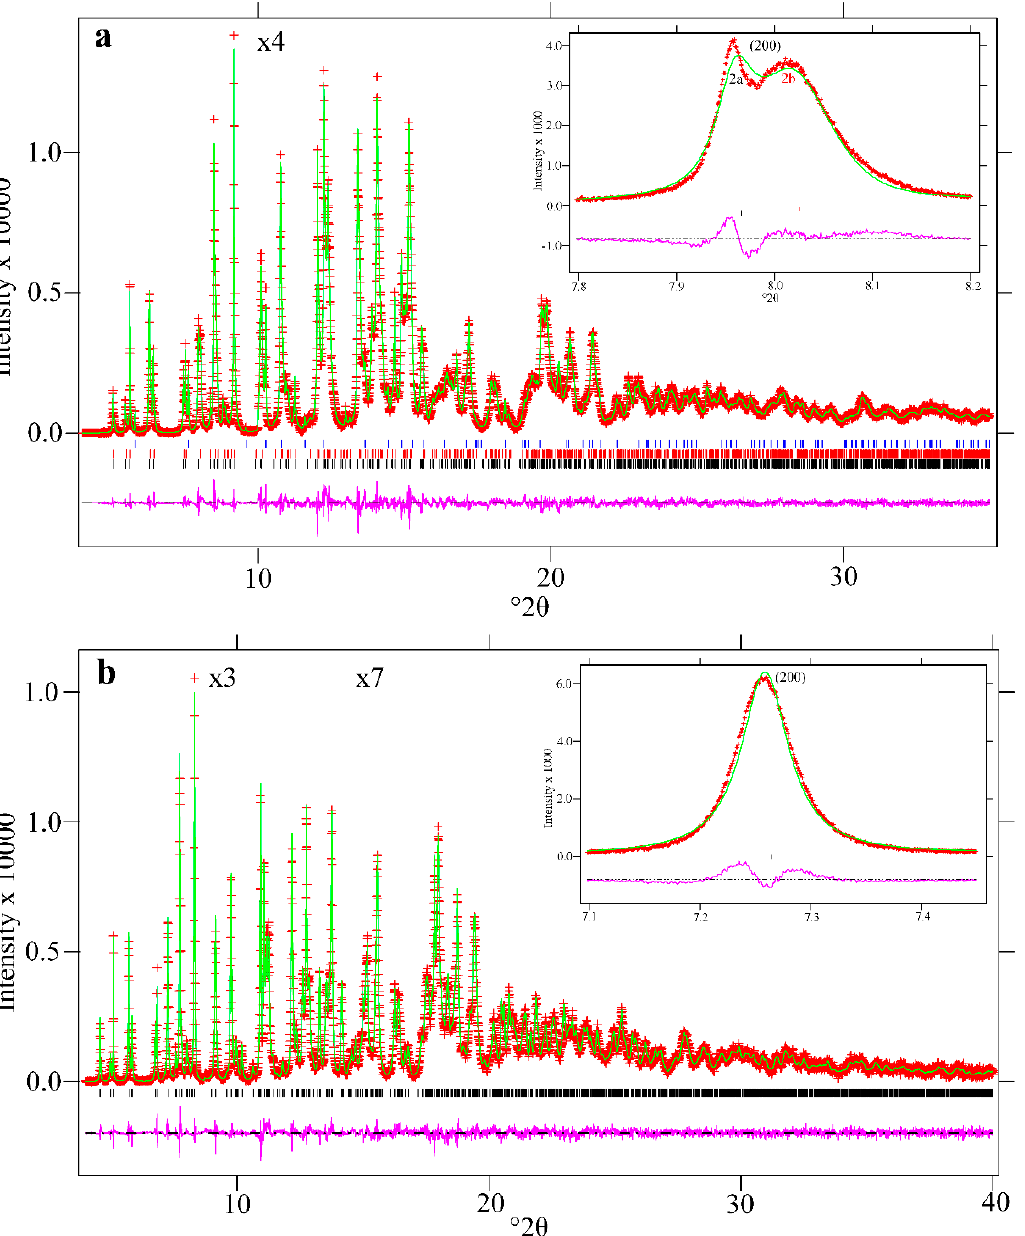
Figure 2. HRPXRD traces for ( a ) sample 2a and ( b ) sample 4a showing calculated (continuous green line) and observed (red crosses) data. The short vertical lines indicate allowed reflection positions. The intensities for the trace and difference curve in ( a ) that are above 10° 2 θ are multiplied by 4. The intensities for the trace and difference curve in ( b ) that are above 9 and 15° 2 θ are multiplied by 3 and 7, respectively. Expanded 200 peak is shown in the inserts. The 200 peak splitting in ( a ) indicates the presence of two different monazite-(Ce) phases. In ( a ), the vertical lines for the three phases are indicated by black for phase 2a [monazite-(Ce)], red for phase 2b [monazite-(Ce)], and blue for phase 2c [xenotime-(Y)].